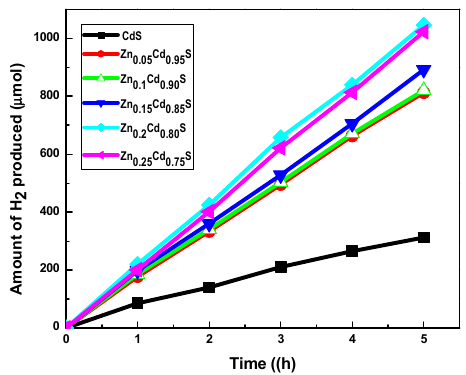
Figure 12. H 2 production as a function of time for pure CdS and Zn x Cd 1 − x S solid solution photocatalysts (0.2 g photocatalyst: 350 W Xe lamp with a cutoff filter ( λ > 420 nm), 0.25 M Na 2 SO 3 and 0.35 M Na 2 S aqueous solutions).